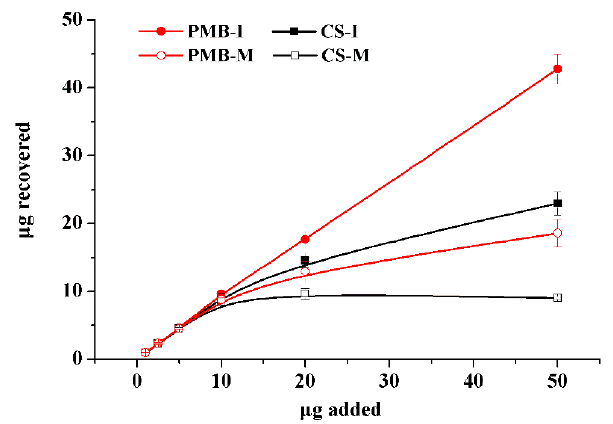
Figure 5. Comparison of binding curves obtained from individual colistin (CS-I), individual polymyxin B (PMB-I), and the mixture of both (CS-M and PMB-M).